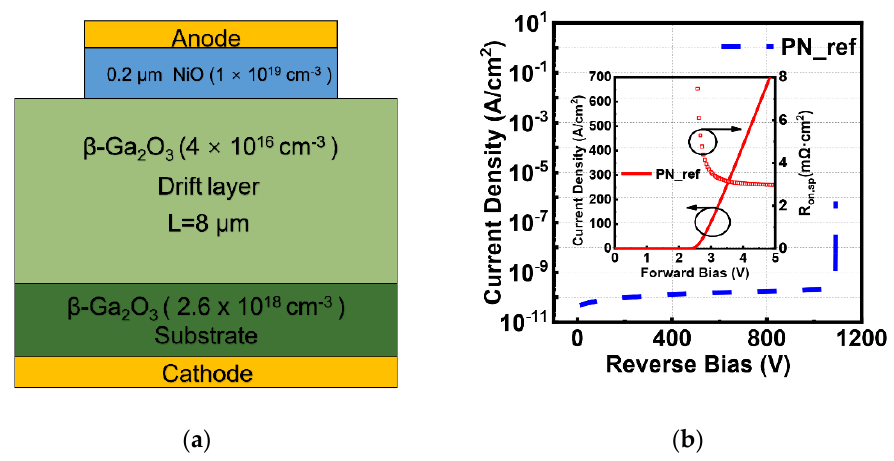
Figure 2. ( a ) Schematic of the vertical NiO/Ga 2 O 3 PN_ref and ( b ) simulated forward J ‐ V character ‐ istics and reverse J ‐ V characteristics of the vertical NiO/Ga 2 O 3 PN_ref. Table 2. The device properties comparison between TCAD simulation and experimental results.